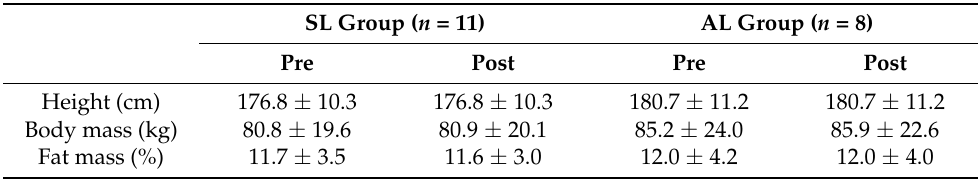
Table 1. General physical characteristics of elite judo athletes pre- and post-strength training in both environmental conditions.